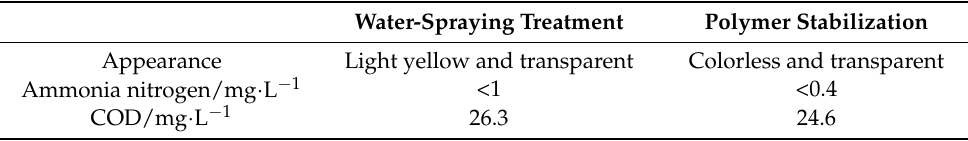
Table 4. Effect of dust suppressants on the quality of surface water.